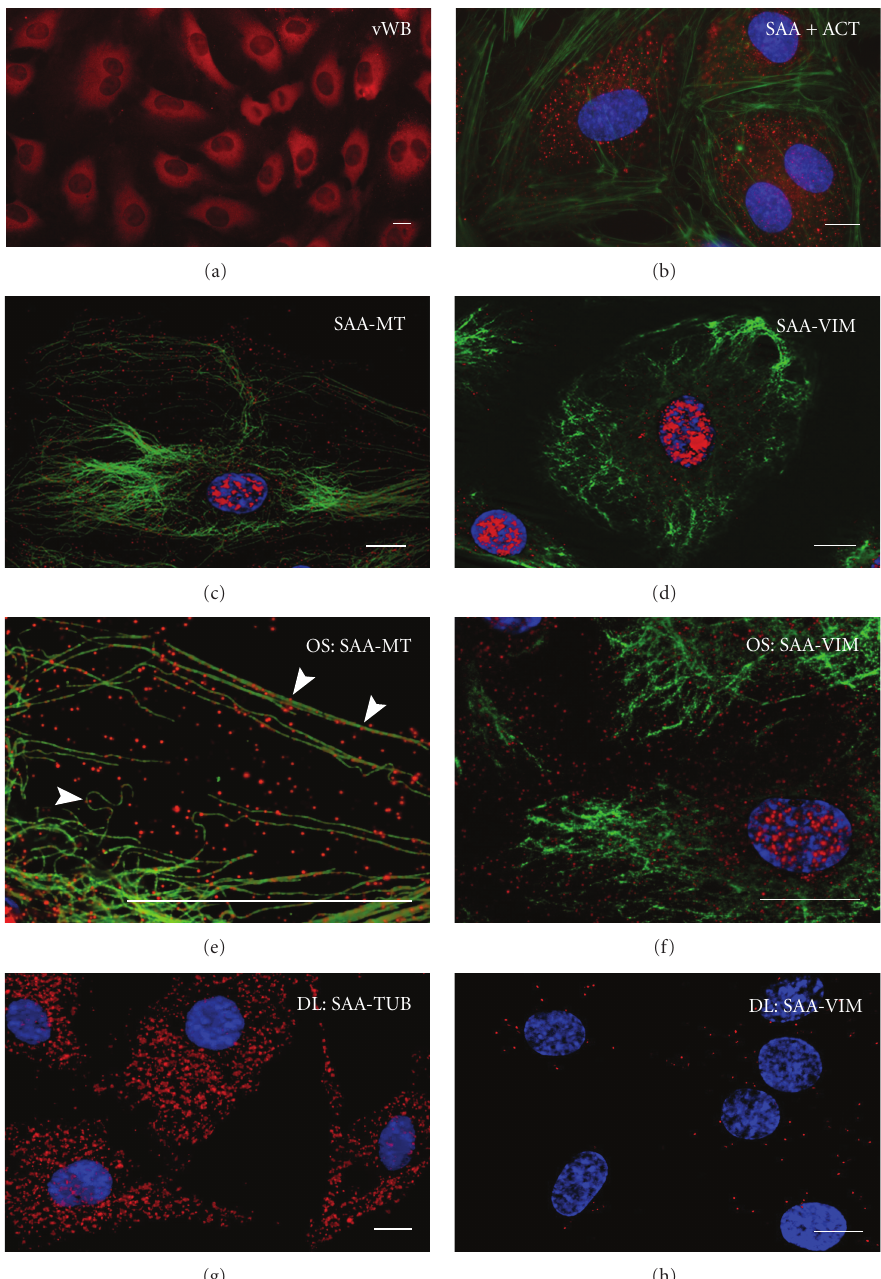
Figure 1: SAA localizes with microtubules in untreated HCAEC, but not with actin filaments or vimentin. In HCAEC Von Willebrand factor (vWB) is demonstrated (red) in all cells (a). In (b) labeling of actin filaments, SAA, and nuclei is presented. In (c) (stack of optical sections) and (e) (larger magnification) SAA labeling can be detected attached to microtubules MT (arrowheads). Vimentin labeling together with SAA does not show any specific colocalization ((d)—stack of optical sections and (f) larger magnification). In (b, c, d, e and f) the labeling of SAA is red, of cytoskeletal elements is green, nuclei is blue. With PLA method colocalization of SAA with tubulin ((g)-TUB) or with vimentin ((h)-VIM) resulted in red reaction product strongly expressed only for tubulin and SAA. Anti-SAA polyclonal antibodies 3, 5, and 6, which target SAA peptides with amino acid sequences 27–44, 59–72, and 68–84, respectively, were used in the designated SAA panels. Bar = 10 μ